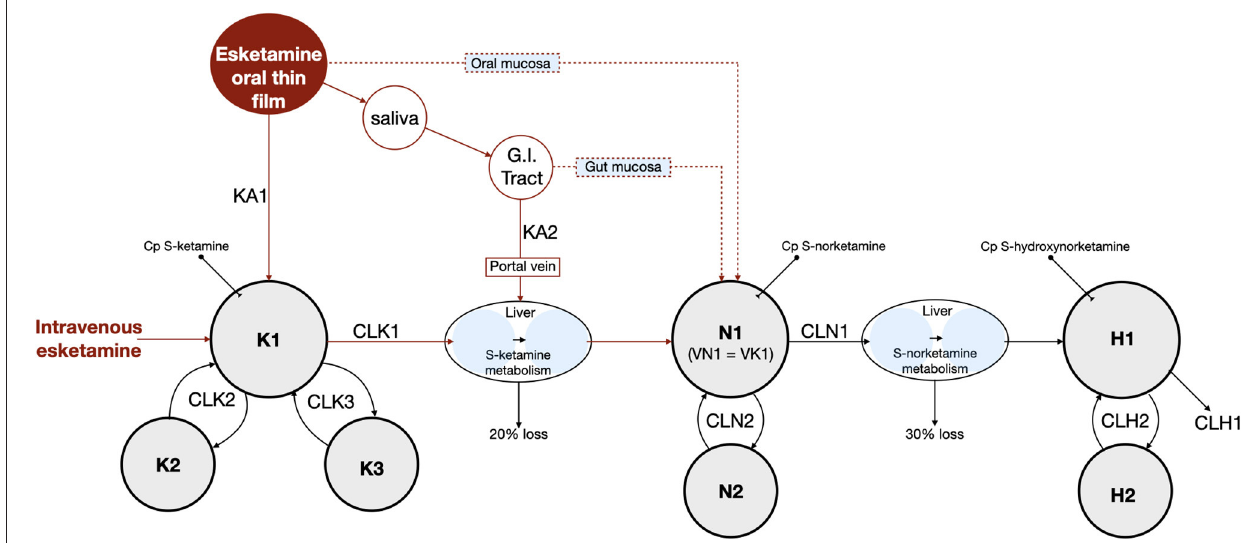
FIGURE 2 | Final pharmacokinetic model. K = S- ketamine, N = S- norketamine and H = S- hydroxynorketamine. KA1 and KA2 are S- ketamine rate constants. G.I. tract = gastrointestinal tract. Cp = plasma concentration. K1, N1 and H1 are the central compartments for S- ketamine, S- norketamine and S- hydroxynorketamine, respectively. VN1 and VK1 are the volumes of the central compartments of S- ketamine and S- norketamine, respectively. Kx, Nx and Hx are the peripheral compartments for S- ketamine, S- norketamine and S- hydroxynorketamine, respectively, with x = compartment 2 or 3. CL = clearance with CLK1 and CLN1 S -ketamine and S-norketamine clearances from the central compartment toward the metabolism compartment, respectively and CLK2, CLK3, CLN2 and CLH2 intercompartmental clearances. CLH1 is the terminal S- hydroxynorketamine clearance. MTT = mean transit (or delay) time with MTTG the mean transit time from the gut to the